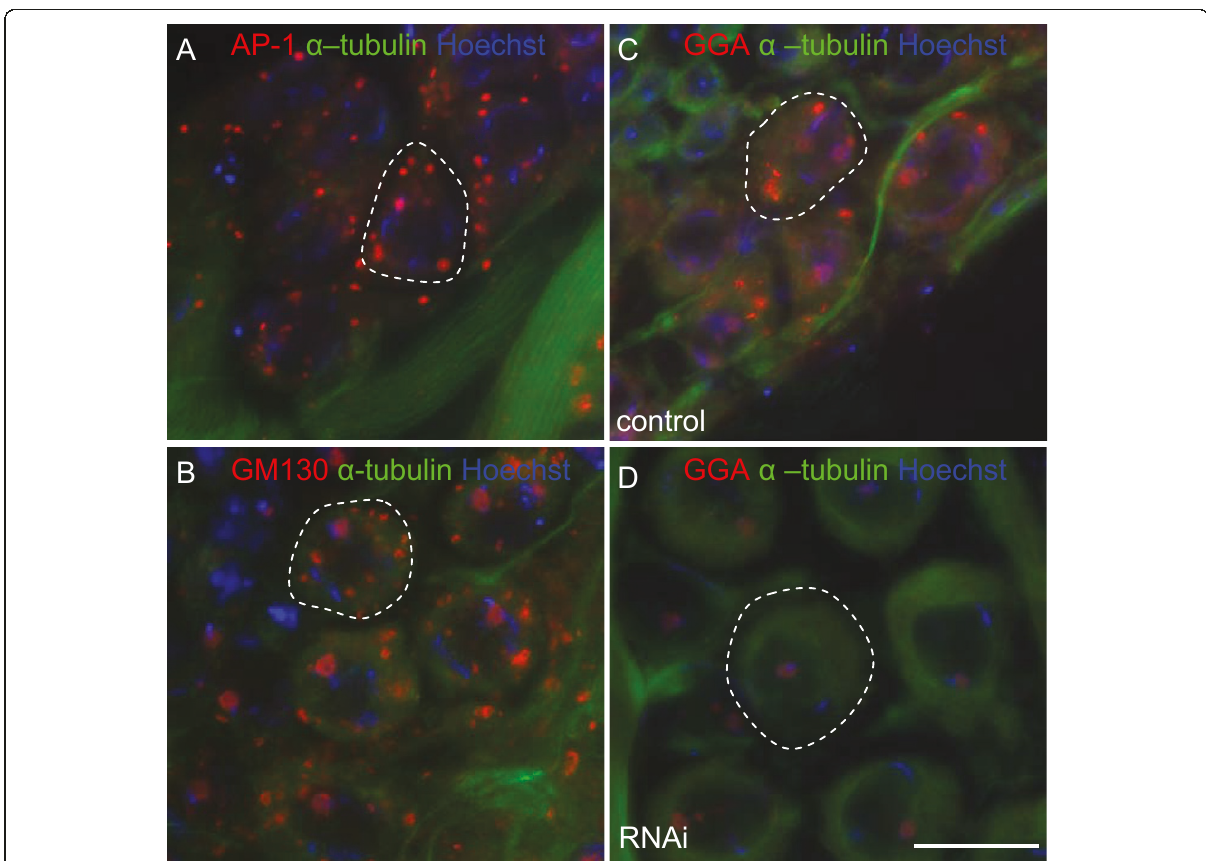
Figure 3 Specific labelling of AP-1 and GGA in Drosophila testes . Spermatocytes were triple labelled for a -tubulin (sperm tails and cytoplasmic microtubules), Hoechst (to determine the stage in sperm development) and either (A) AP-1, (B) GM130, and (C) GGA. Note that AP-1, GGA and GM130 all localise to large peripheral puncta reminiscent of Golgi mini stacks. (D) Spermatocytes from GGA knockdown flies were triple labelled for a -tubulin, Hoechst and GGA. Note that there is loss of the punctate cytoplasmic GGA labelling, demonstrating the specificity of the GGA antibody (the knockdown flies are further characterised in Figures 6 and 7) Bar, 20 μ